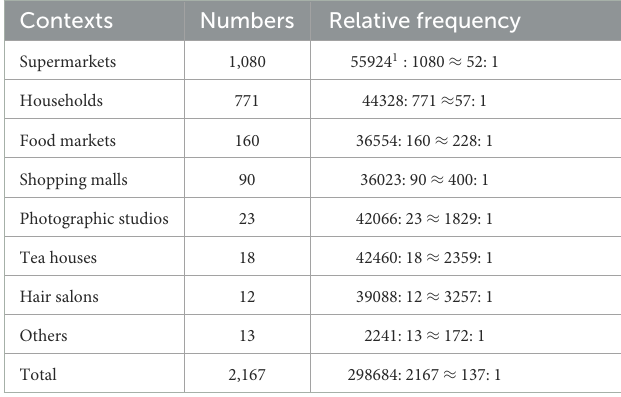
TABLE 1 The number and relative frequency of dai in eight different